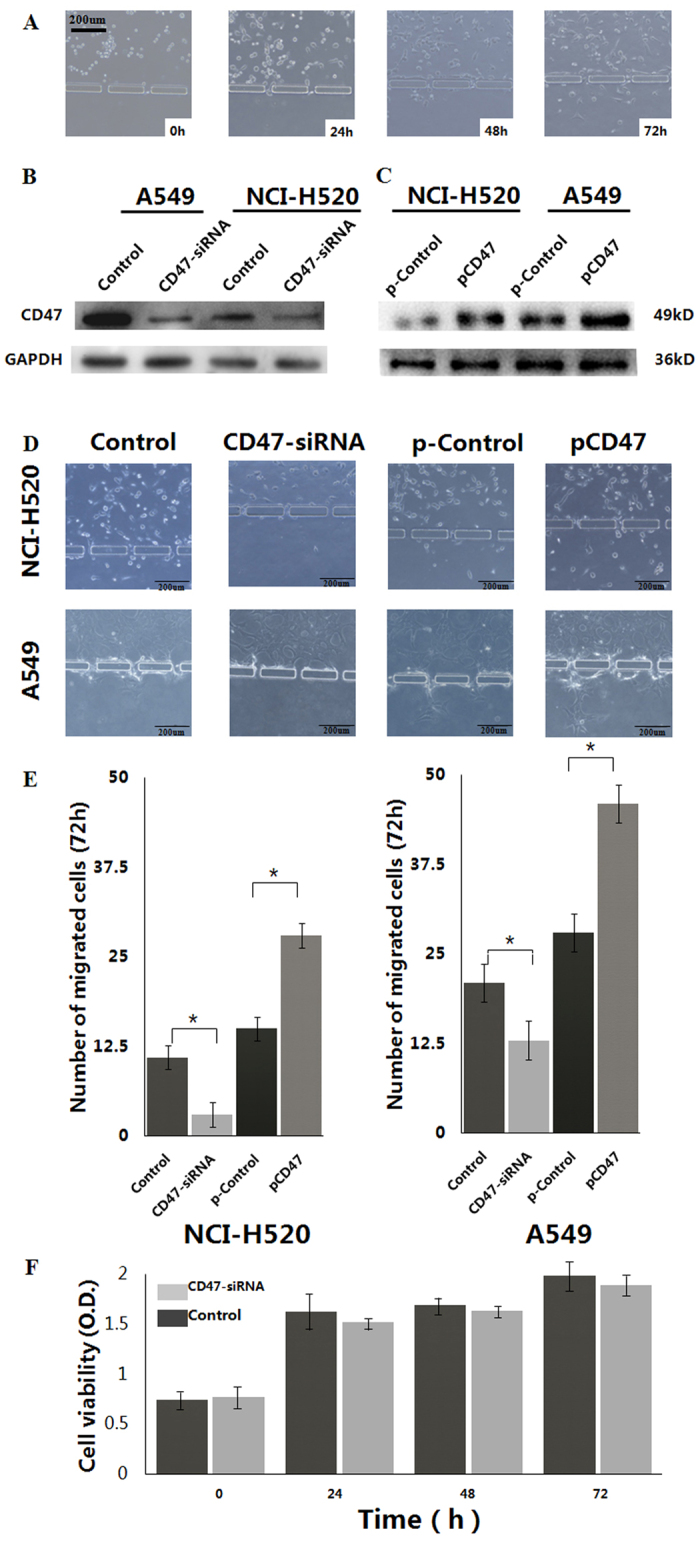
CD47 critically controls the migration/invasion of NSCLC cells in vitro.(A) Migration/invasion of HCI-H520 cells to the gel micro-channel at different time points. (B) Western blotting analysis of CD47 protein level in A549 and HCI-H520 cells transfected with control siRNA (control) or siRNA against CD47 (CD47-siRNA), respectively. (C) Western blotting analysis of CD47 protein level in A549 and HCI-H520 cells transfected with control vector (pControl) or pcDNA3.1-3xFlag-CD47 (pCD47), respectively. GAPDH was used as a loading control. (D) Representative images of A549 and HCI-H520 cells were transfected with CD47-siRNA and pcDNA3.1-3xFlag-CD47, respectively. (E) Quantification of migrated A549 and HCI-H520 cells in comparing the CD47-siRNA treated group or pcDNA3.1-3xFlag-CD47 treated group with the control groups; *P < 0.05. (F) MTT assay for cell viability at different time points after siRNA transfection.